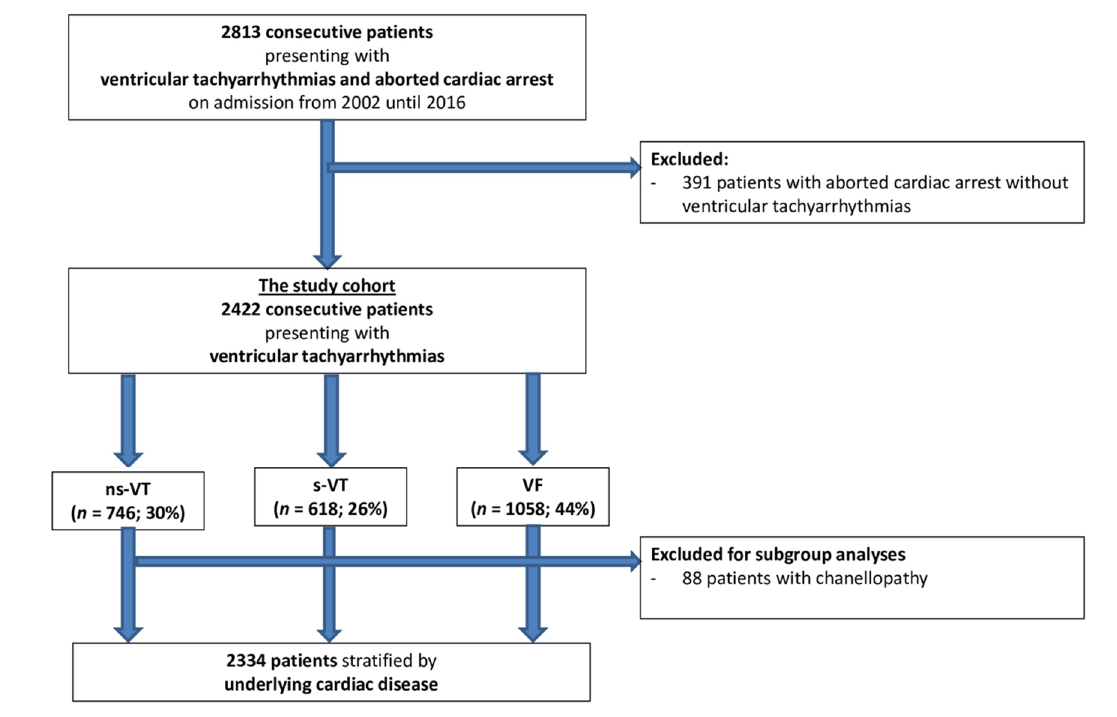
Figure 1. Study population. Table 1. Baseline characteristics of the entire study